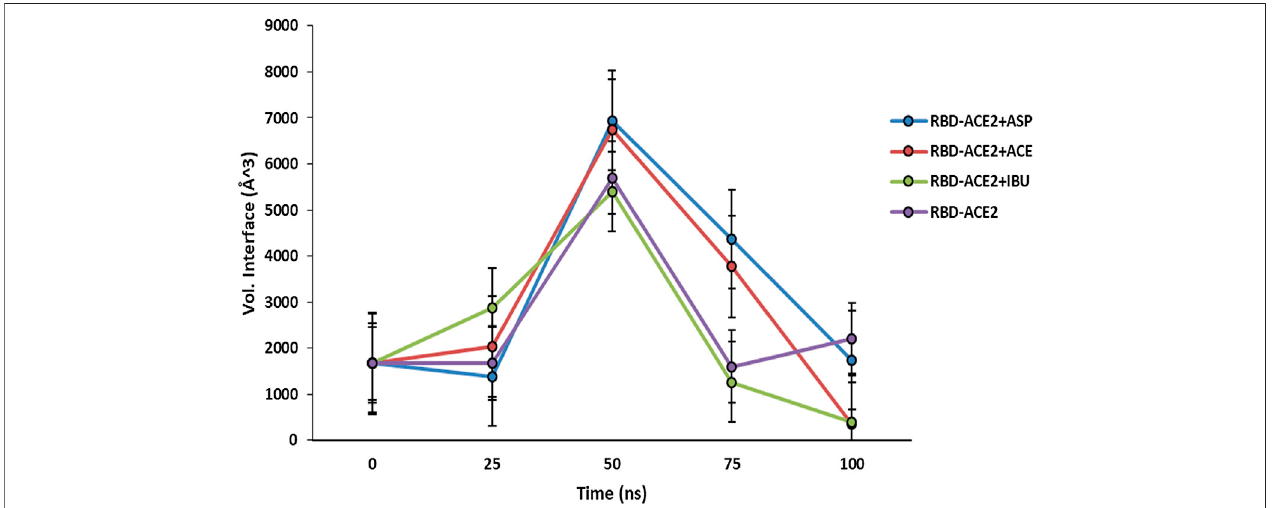
FIGURE 2 | Fluctuation of volume of cavity in the interface RBD-ACE2 protein complex in presence of Ibuprofen (RBD-ACE2+IBU), Aspirin (RBD-ACE2+ASP) and Acetaminophen (RBD-ACE2+ACE) at 100 ns. As acontrol, RBD-ACE2protein complex without ligands was simulated (RBD-ACE2). Vol. Interface, Volume ofthe union pocket in the interface. The PockDrug-Server was used applying the Fpocket method.